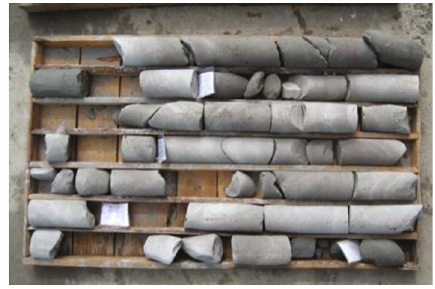
Figure 3: Back fi ll in GZK2 borehole.